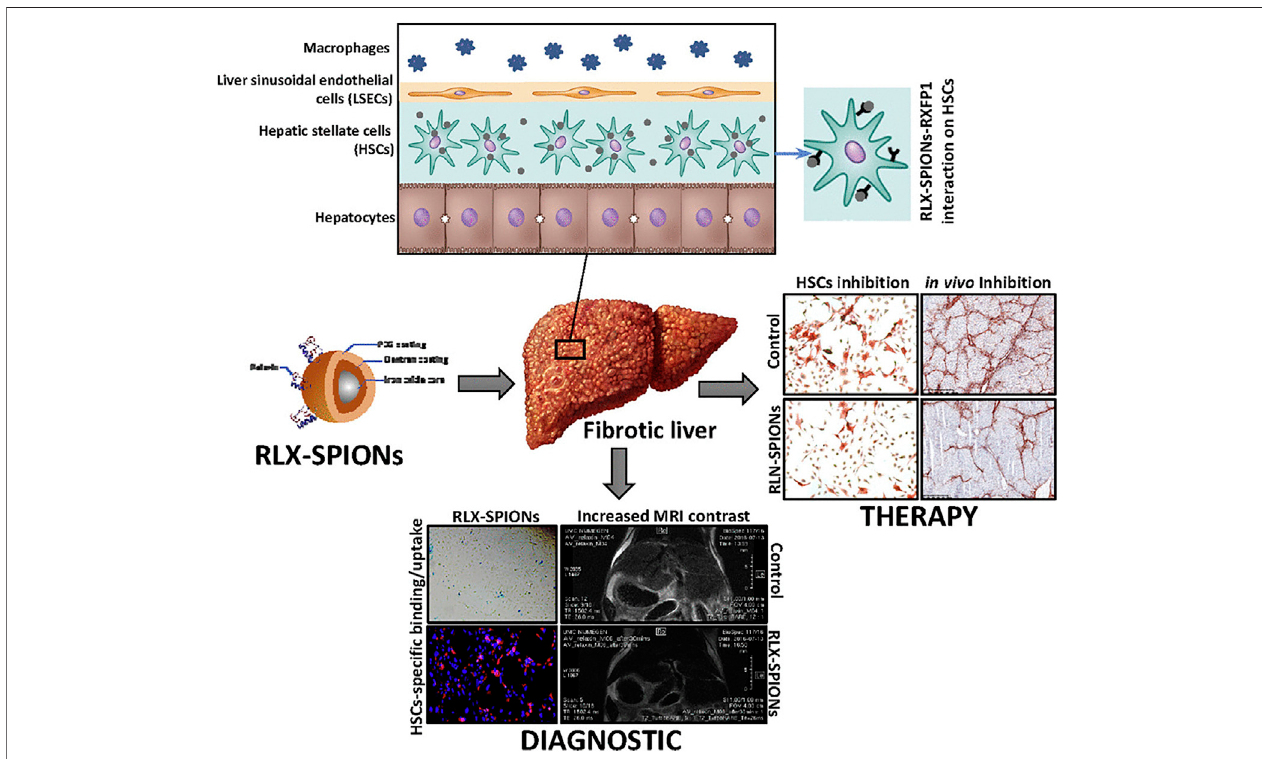
FIGURE 5 | The role of engineered Relaxin in the treatment and diagnosis of liver cirrhosis. Reproduced with permission (Nagórniewicz et al., 2019). Copyright 2019, Elsevier Inc .